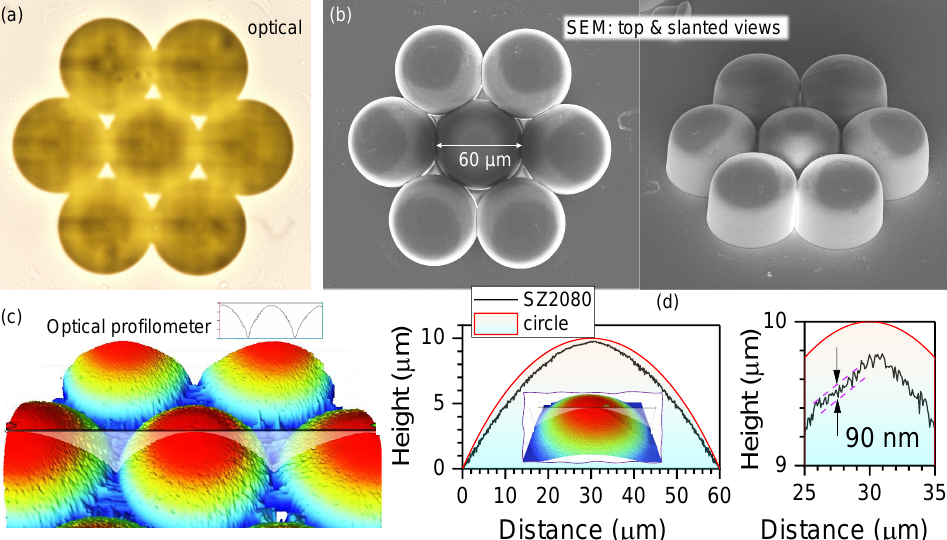
Figure 2. ( a ) Optical microscopy image (transmission) of the fabricated MLA. Polymerisation of the outer shell was carried out using concentric fs-DLW from larger-to-smaller diameters. ( b ) Top and 45 ◦ tilted view of SEM images of the fabricated MLA; the diameter of the microlens is 60 ± 0.3 µ m. ( c ) 3D topographic view (50 × ) of the fabricated MLA. ( d ) Height profile and corresponding circle curve; inset: 3D topographic view (115 × ). The entire height of the structure is comprised of 12 µ m pedestal and 10 µ m lens. The min–max roughness near the centre of the lens was 90 ± 10 nm which was < λ /10 for IR